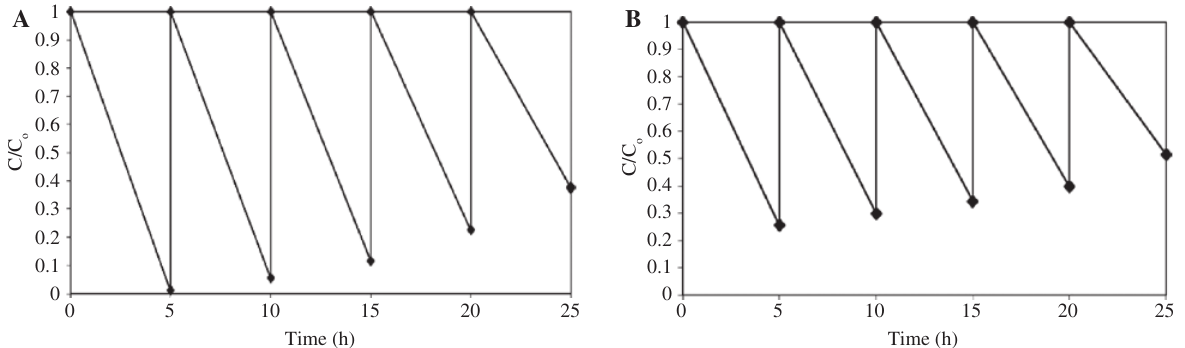
Figure 13: Recyclability of a ternary composite photocatalyst for the decolorization of (A) reactive black 5 and (B) methylene blue dyes under visible light